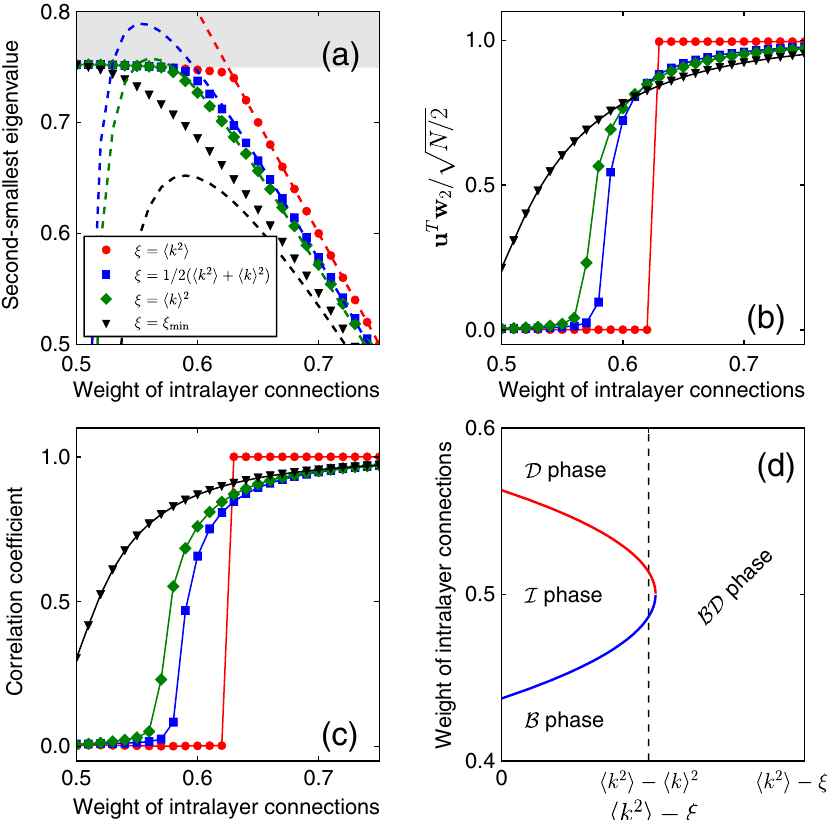
FIG. 2. Phase diagram. We consider interconnected networks composed of two layers of size N ¼ 8192 with intra- and interlayer degrees obeying a Poisson distribution with average h k i ¼ 32 . (a) Second-smallest eigenvalue ν 2 as a function of the weight of the intralayer connections p . For values of the correlation term ξ in the range ½h k i 2 ; h k 2 i(cid:1) , the results of numerical computations (symbols) are in very good agreement with our analytic predictions (dashed lines). The critical point p þ c is determined as the point for which the dashed lines enter the spectral band (gray area). For ξ ¼ ξ , our predictions fail to correctly describe how ν 2 changes as a function of p . ffiffiffiffiffiffiffiffiffi p min N= 2 (b) As in Fig. 1, we monitor the transition between the D and the I phases, by looking at the order parameter u T w 2 = . As ξ decreases, the change of the order parameter becomes smoother, and the value of the critical point gets closer to p ¼ 0 . 5 . For ξ